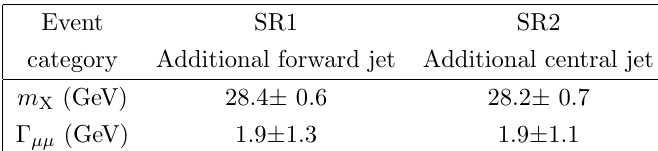
Table 2 . The mass and width of the event excess obtained in the 8 TeV analysis. signi(cid:12)cance of the excess observed in SR2 at 8 TeV is 2.9 s.d. The best (cid:12)t values of the hypothetical signal mass m and its width (cid:0) obtained from the (cid:12)t to the 8 TeV data are (cid:22)(cid:22) X listed in table